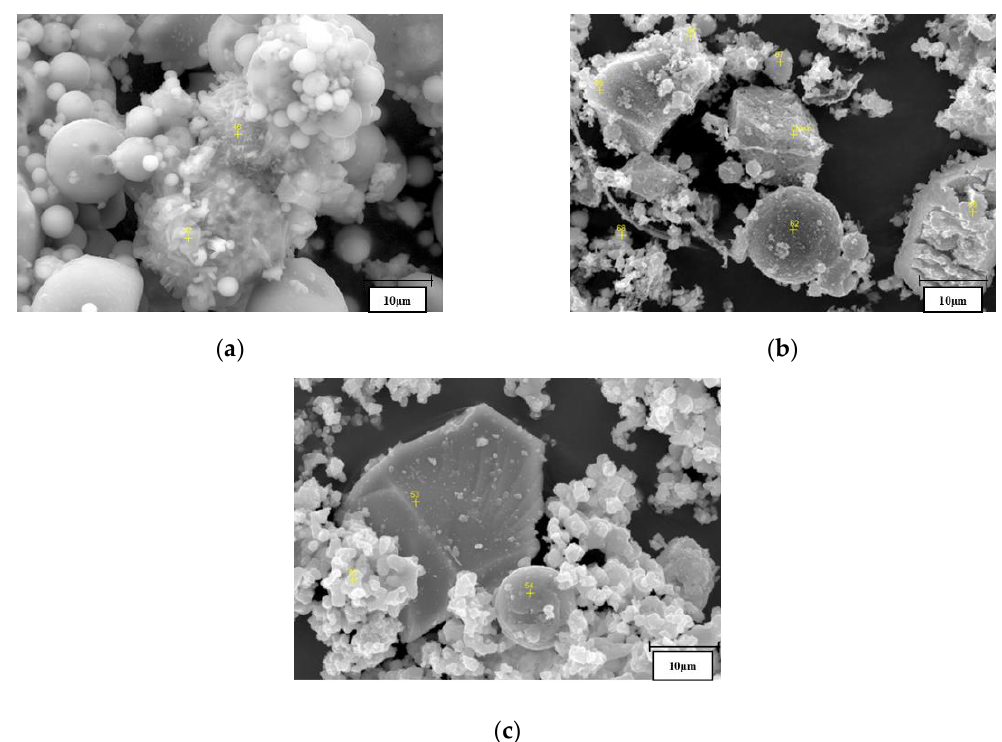
Figure 3. SEM pictures in 10- µ m scale of fly ashes: ( a ) RFA, ( b ) CFA, and ( c )